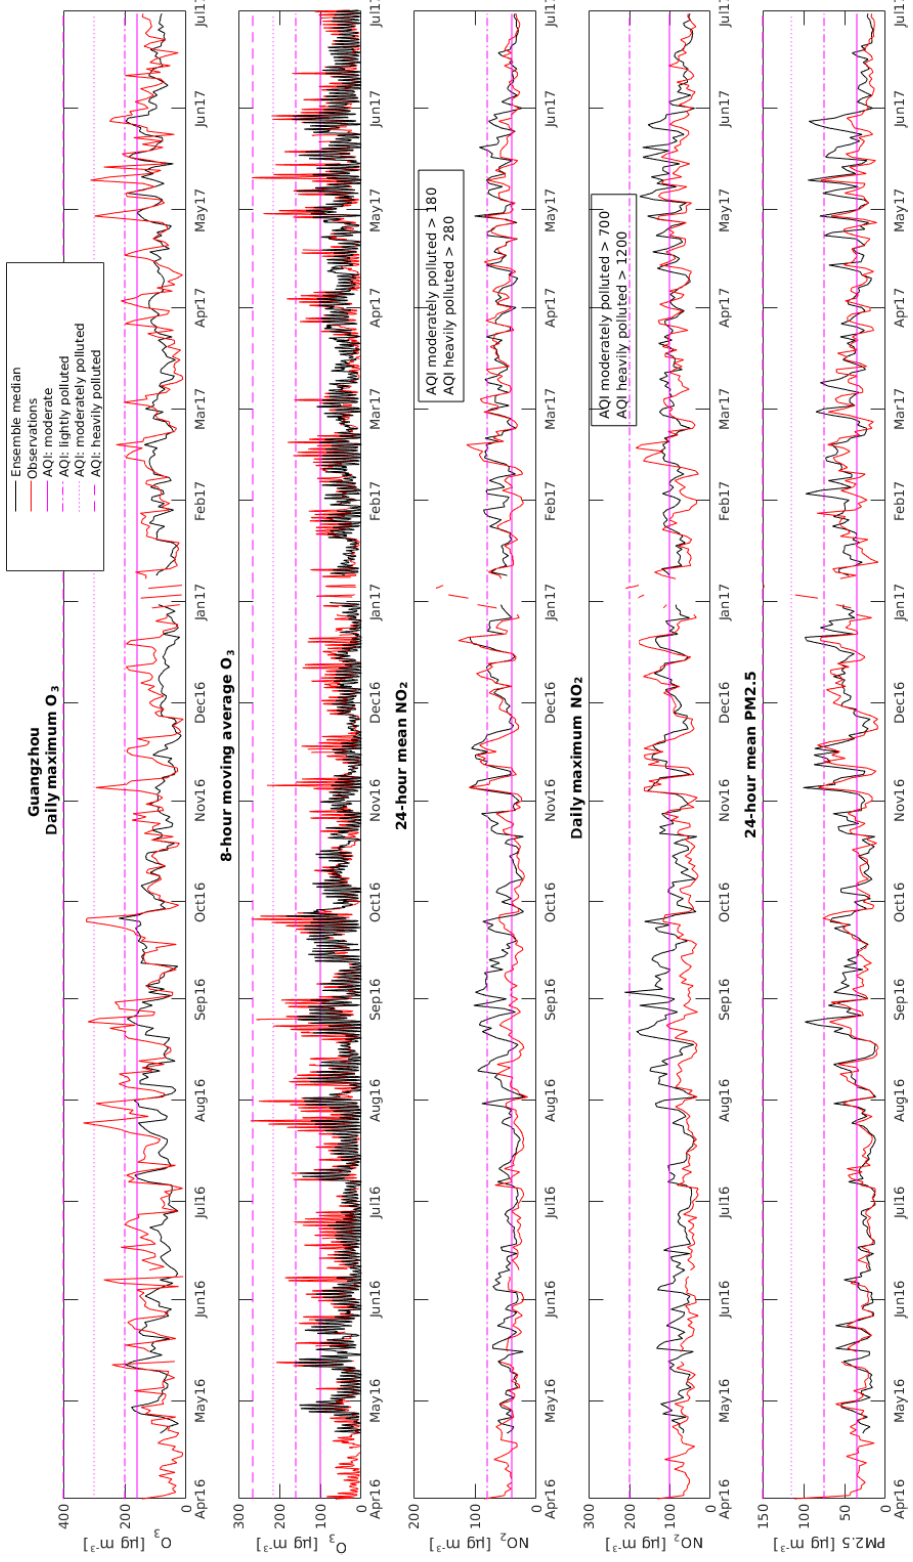
Figure 12. Calculated (ensemble median) and observed time series of daily maximum O 3 , 8h moving average O 3 , 24h mean NO 2 , daily maximum NO 2 , and 24h mean PM 2 . 5 for Guangzhou from April 2016 until June 2017. Geosci. Model Dev., 12, 1241–1266,